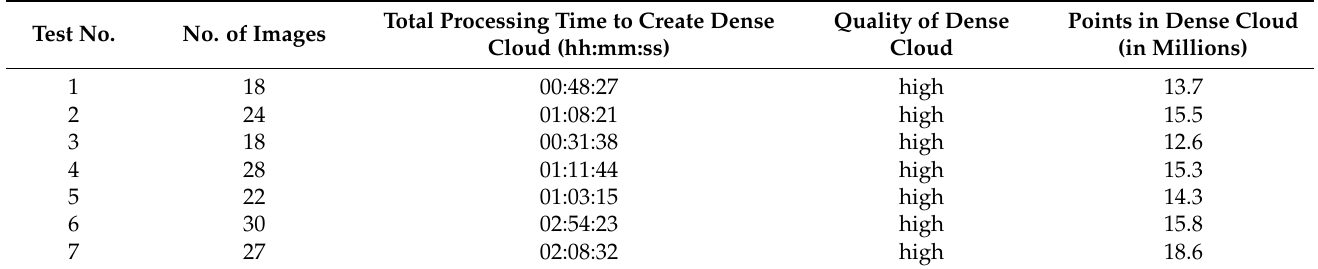
Table 5. Boundary conditions and measured volume of flushing cone for tests conducted in Case Study III.